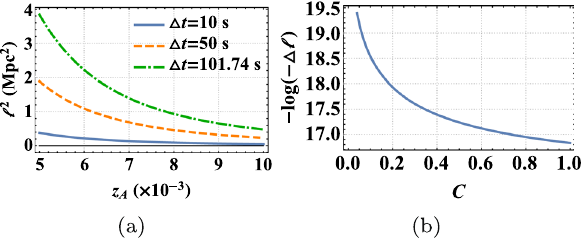
Fig. 1 The constraint on the AdS 6 radius from the joint observations of GW170817 and GRB 170817A by the relation (52). a The AdS 6 radius with respective to the source redshift. The redshift ranges from z A = 0 . 005 to z A = 0 . 01. The parameter C is set to C = 1 / 2. The values of the time delay between the detections of the two signals are chosen as (cid:17) t = 10s (blue solid curve), (cid:17) t = 50s (orange dashed curve), and (cid:17) t = 101 . 74s (green dashed and dotted curve). The black solid curve with (cid:17) t = 0s gives a lower boundary of the AdS 6 radius. b The contribution of the brane motion (cid:11)( t ) to the constraint on the AdS 6 radius. The values for the other parameters are z A = 0 . 5 and (cid:17) t = 101 .